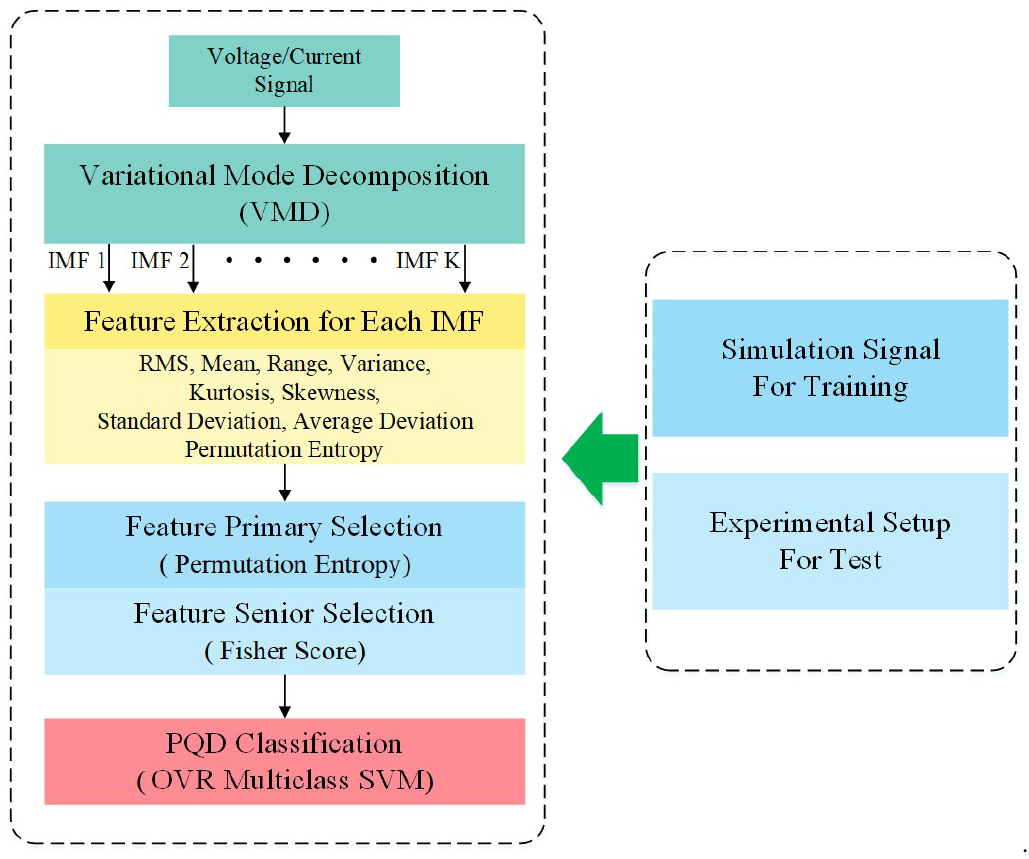
Figure 2. Main flow chart of the proposed method.